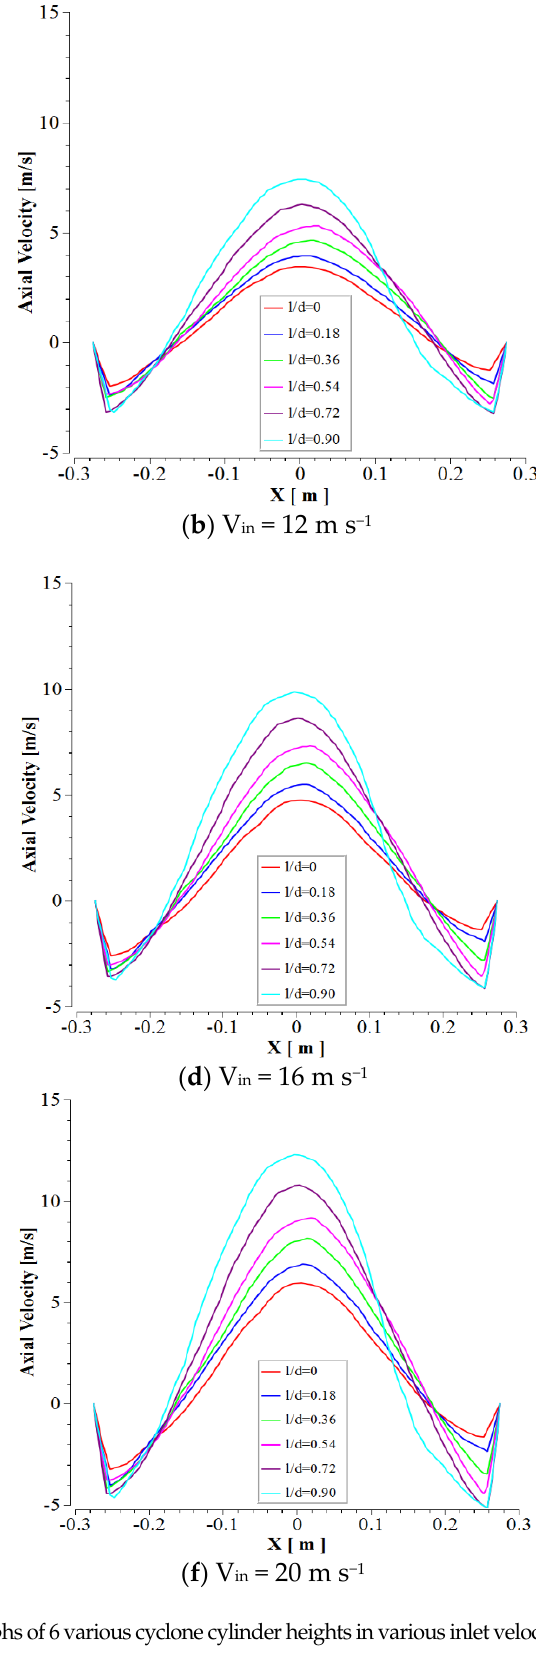
value of inlet velocity as the axial velocity was mostly affected by the volumetric flow rate (air flow rate).